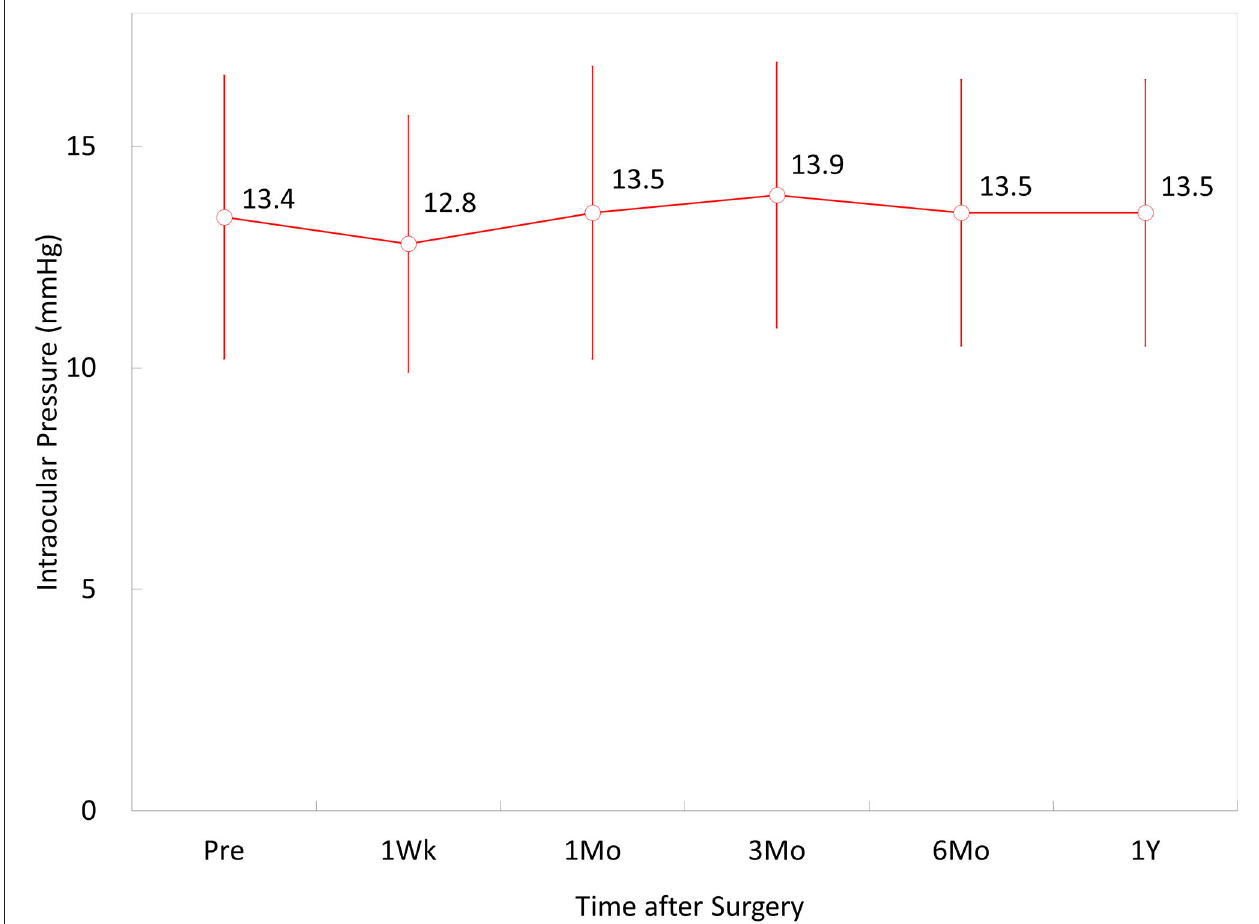
FIGURE 2 | Time course of changes in intraocular pressure (IOP) after implantable Collamer lens (ICL) implantation in eyes with low myopia.